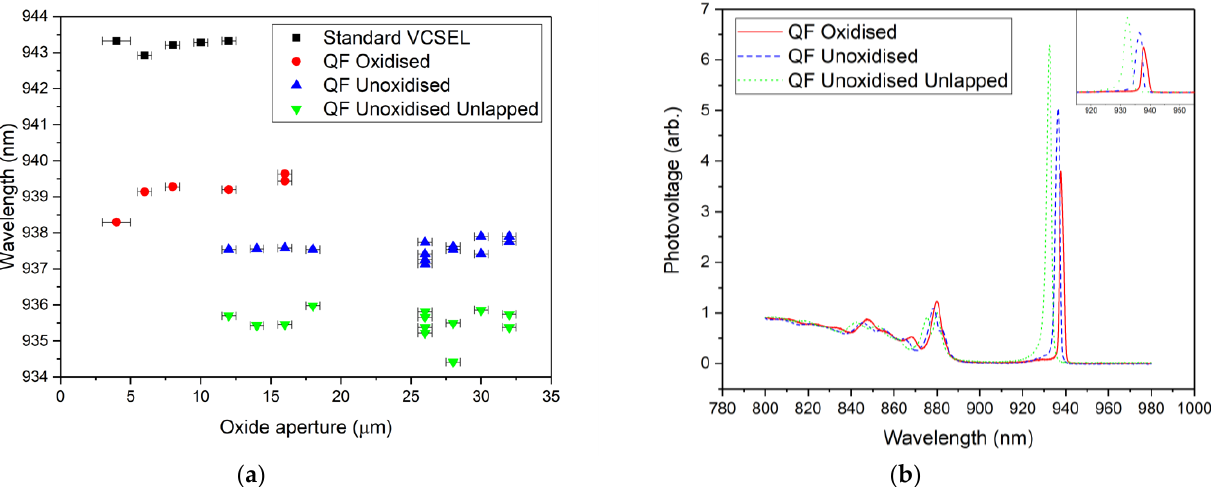
Figure 7. ( a ) Lasing wavelengths for all devices; ( b ) photovoltage spectra for QF VCSEL samples showing the variation in cavity resonance wavelength.